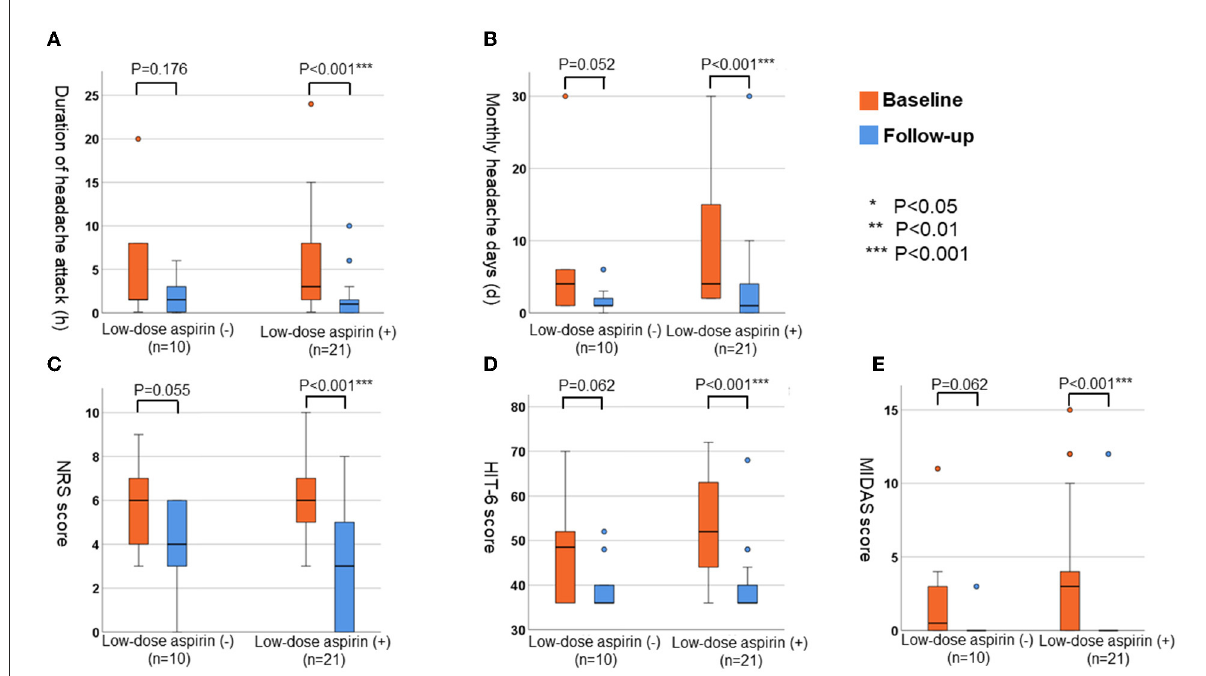
FIGURE3 The changes of parameters for headache in patients with or without low-dose aspirin. (A) Average duration of headache attack (h). (B) Monthly numbers of headache days (d). (C) NRS score. (D) HIT-6 score. (E) MIDAS score.